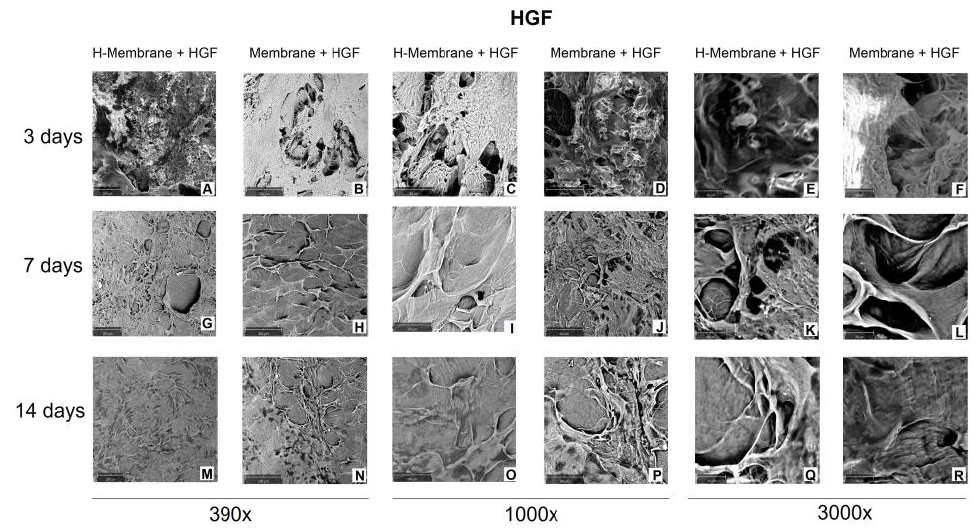
Figure 4. Scanning electron micrograph (SEM) images of HGFs seeded on H-Membrane and Mem- brane at 3 ( A – F ), 7 ( G – L ), and 14 ( M – R ) days. (Magnification = 390, 1000, and 3000×).